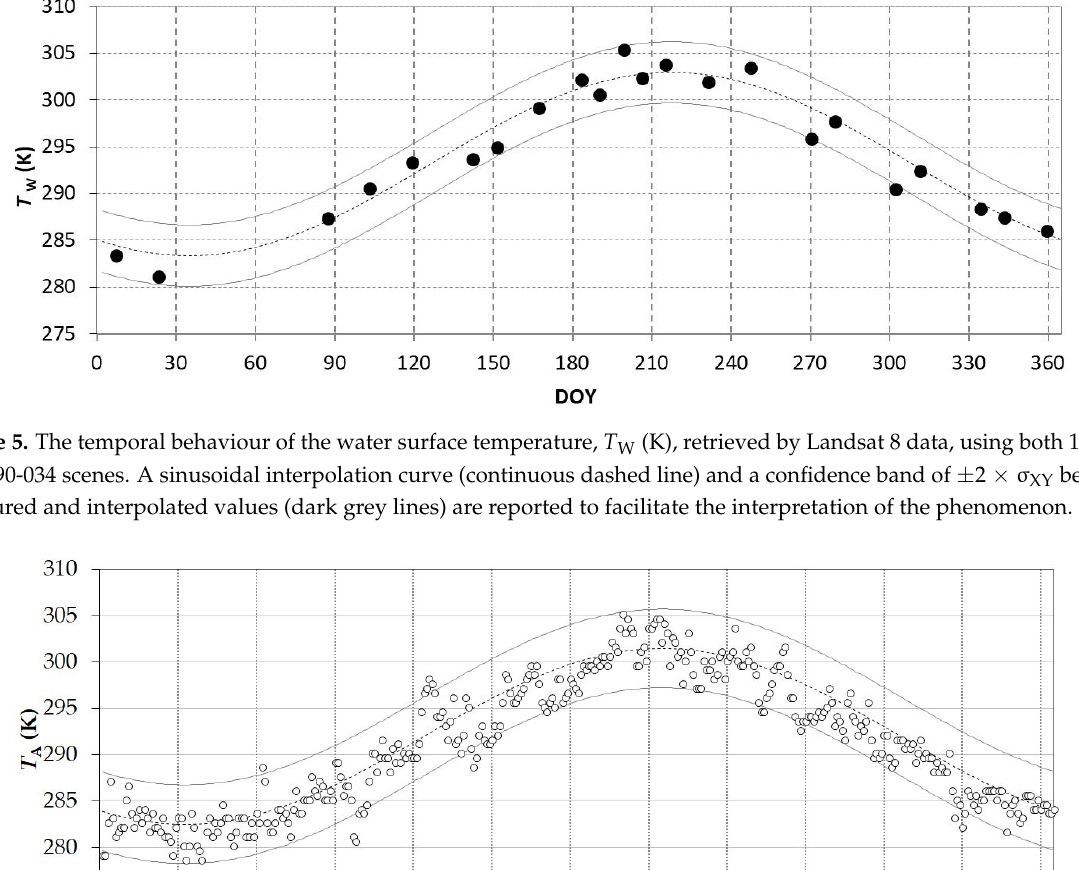
Figure 6. The temporal behaviour of air temperature, T A (K), measured in situ. A sinusoidal interpolation curve (continuous dashed line) and a confidence band of ±2 × σ XY between measured and interpolated values (dark grey lines) are reported to facilitate the interpretation of the phenomenon.